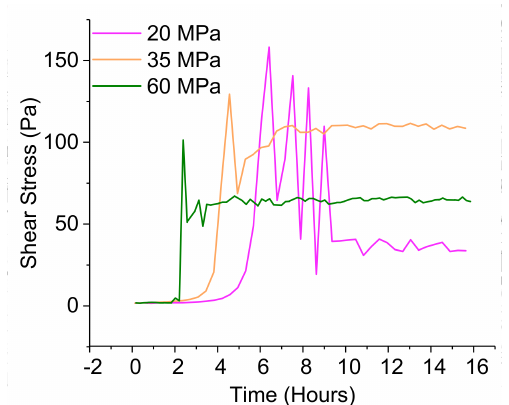
Figure 2. The 65—5 liquid (formulation described in Table 1) is heated to 70 ◦ C and pressurized to 20, 35, and 60 MPa. The data clearly show a decrease in gel time with increasing pressure, suitable to more extreme wellbore environments. Reprinted (adapted) with permission from [9]. Copyright (2018) American Chemical